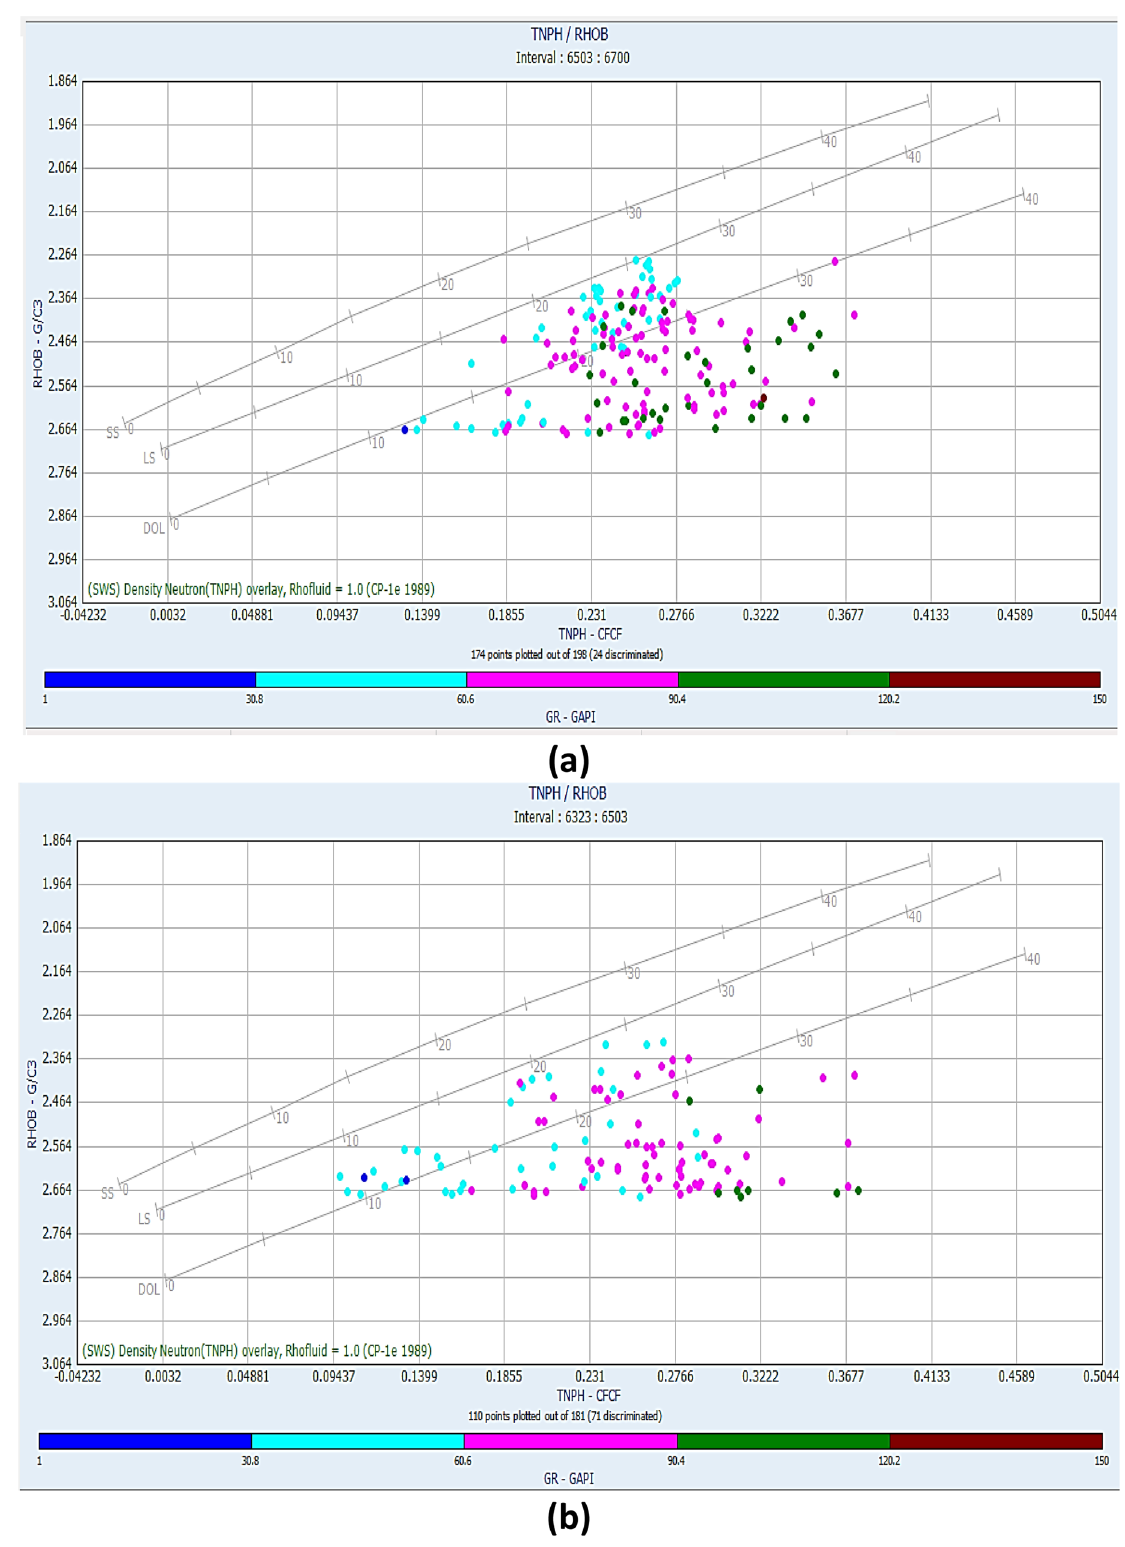
Fig. 17 Neutron-Density (TNPH-RHOB) cross-plots for a the Lower Bahariya Member, and b the Upper Bahariya Member in Kh_45